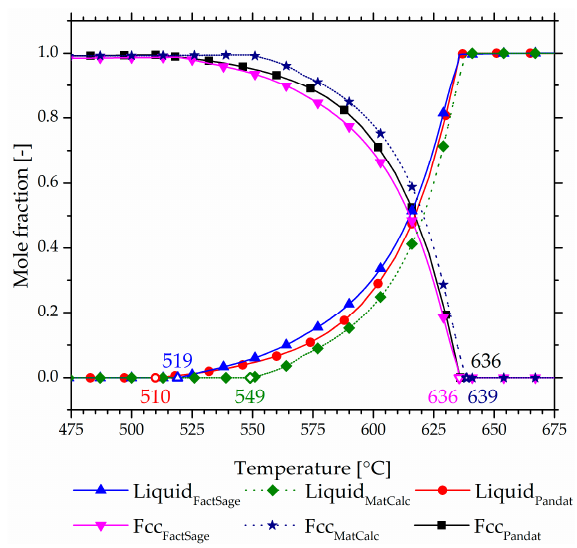
Figure 1. Thermodynamic calculation of solidus and liquidus temperatures of experimental alloy #38 using FactSage ® , MatCalc, and Pandat™.